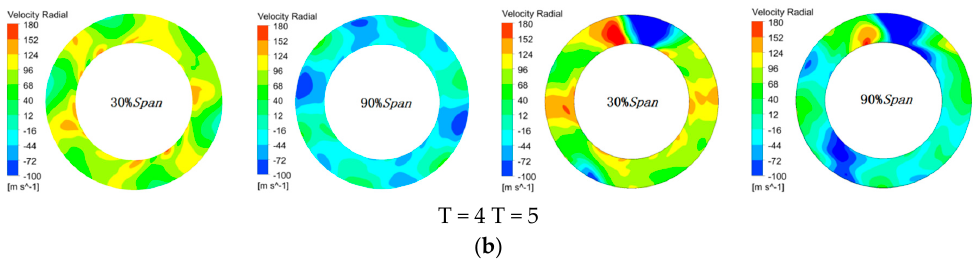
Figure 22. Radial velocity contour of different blade height sections at different times: ( a ) the diffuser radius ratio is 1.8; ( b ) the diffuser radius ratio is 1.5.